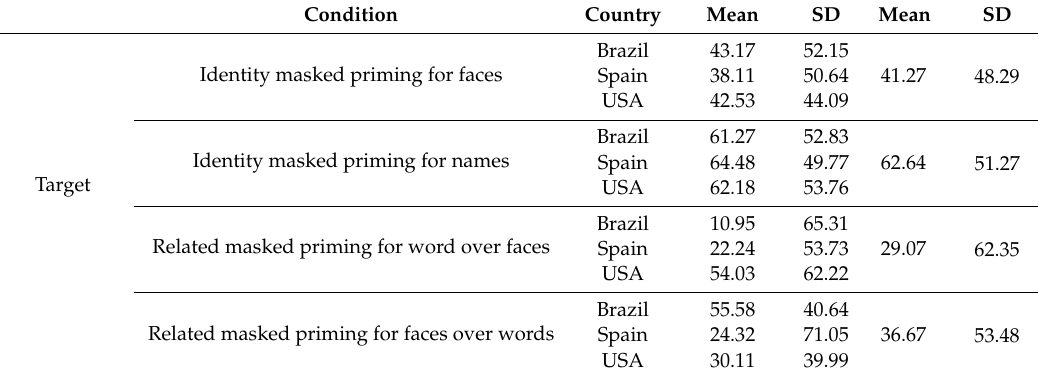
Table 3. Masked repetition priming e ff ects for Experiment 2 across countries and